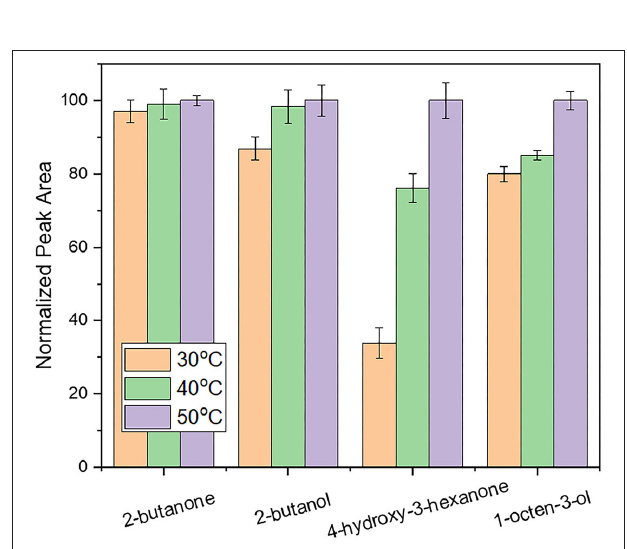
FIGURE 2 | Evaluation of the influence of extraction temperature on response using an extraction time of 30min and a desorption time of 5min. Other parameters as described in the experimental